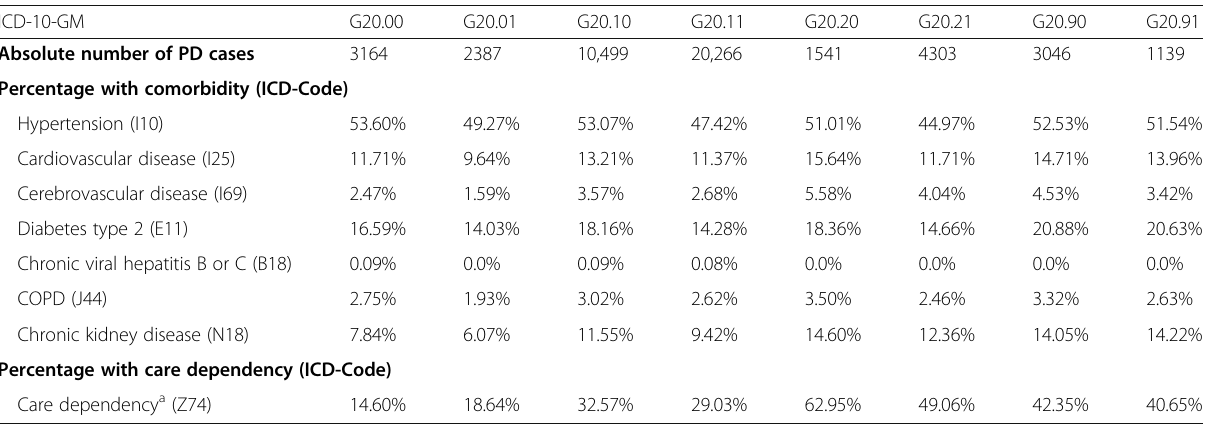
Table 1 Percentage of comorbidities with assumed high risk for a severe course of COVID-19 5 and care dependency given for all inpatient cases of PD ( n = 46,345) in Germany from the year